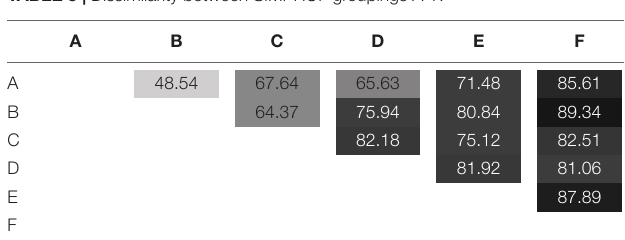
Shading from light grey to dark grey corresponds to lowest to highest dissimilarities in percent. DB, Duse Bay; PGC, Prince Gustav Channel; S, South; CO,